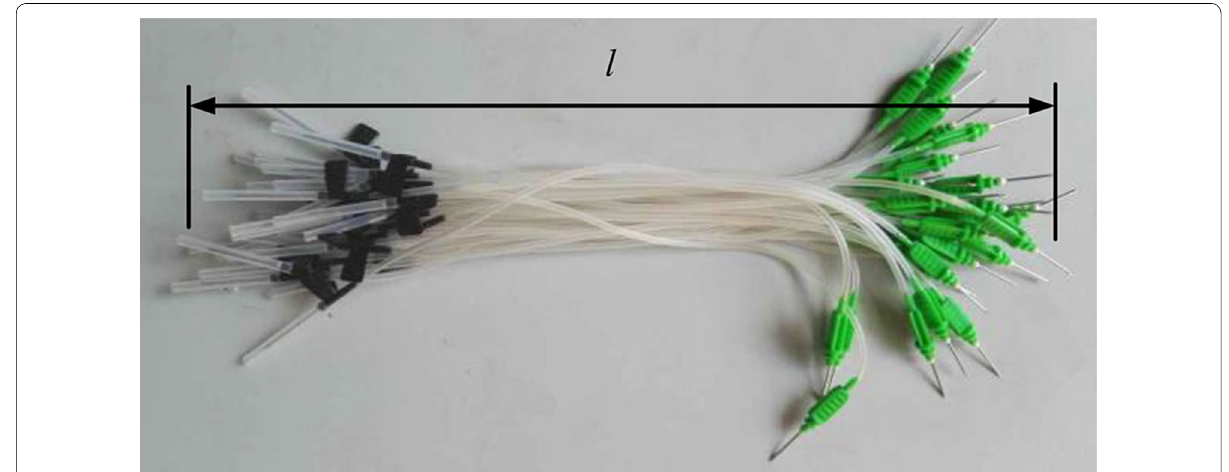
Figure 2 Length measurement of blood collection needles in the stacking state